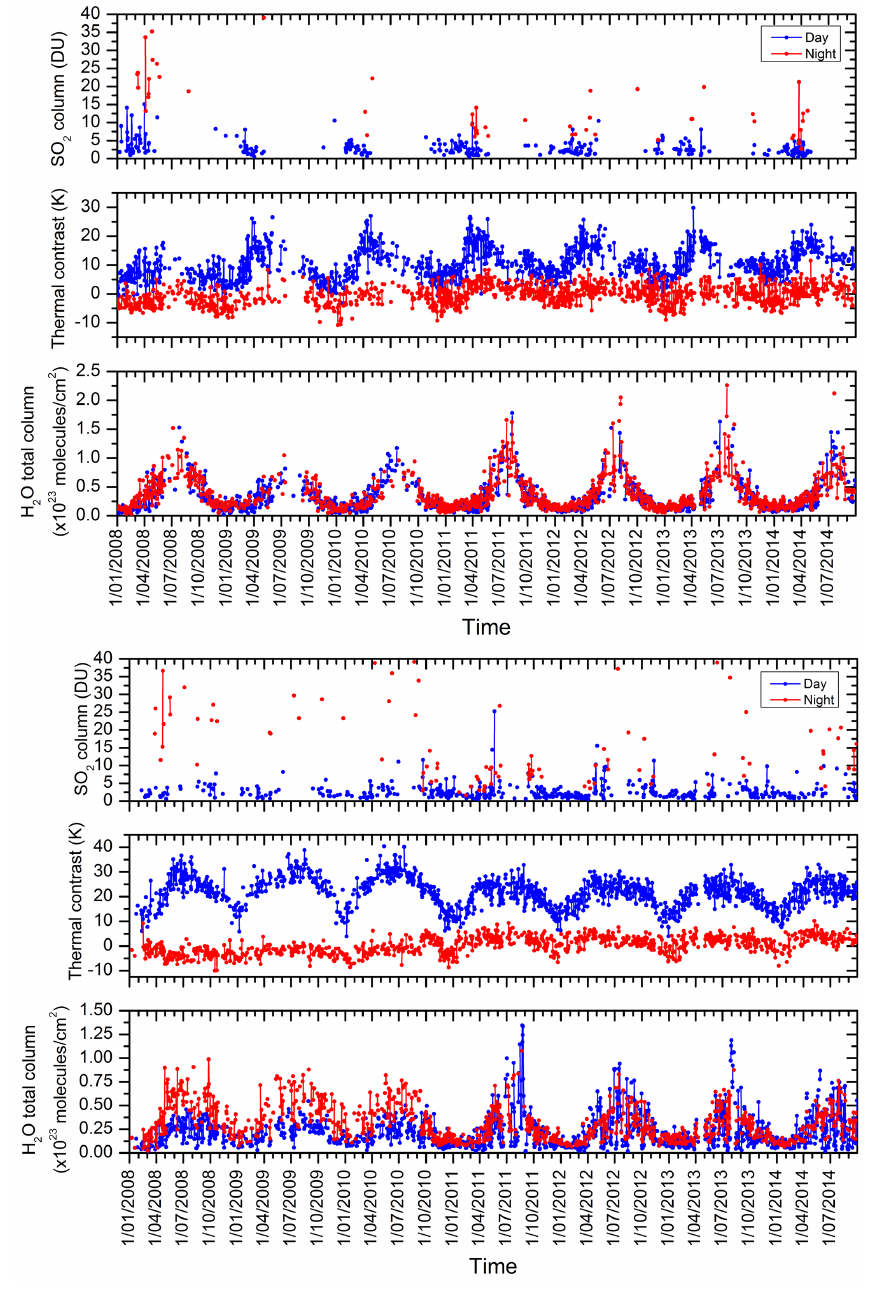
Figure 8. Daily averages of near-surface SO 2 (DU), thermal contrast (K) and H 2 O total column (moleculescm − 2 ) above Beijing (top panels) and Sar Cheshmeh (bottom panels). Averages have been calculated within a radius of 125 and 75km of Beijing and Sar Cheshmeh respectively. Daytime measurements are indicated in blue and night-time measurements are indicated in